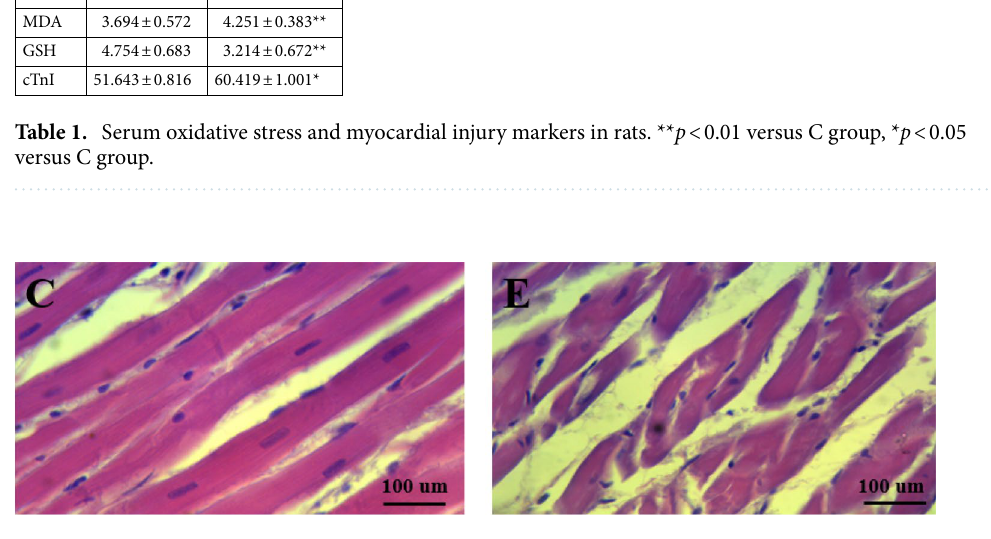
Figure 1. HE staining to observe myocardial morphology and